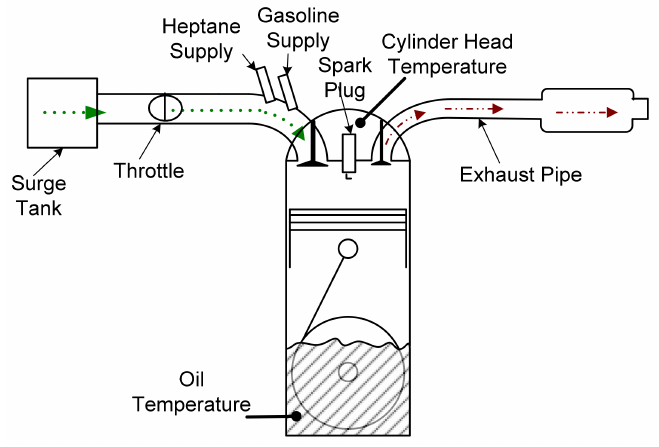
Figure 1. Configuration of the proposed homogeneous charge compression ignition (HCCI)